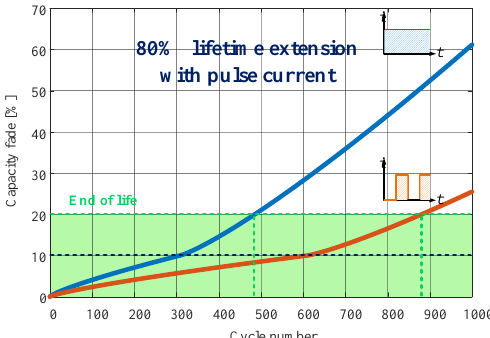
Figure 1. Lifetime extension using pulsed current charging compared with constant current